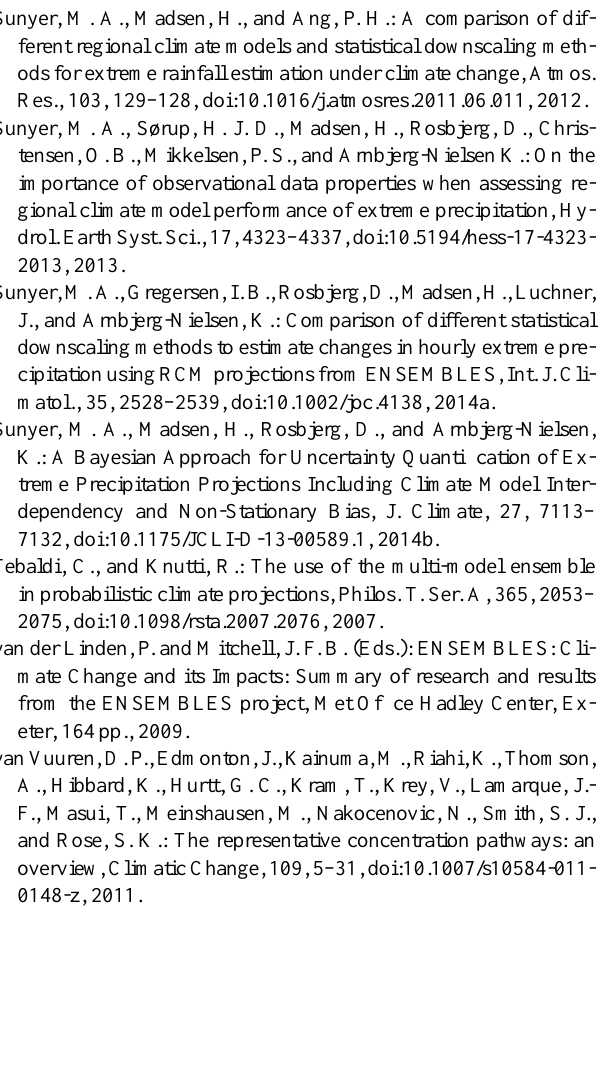
Figueras, T., and Jameleddine, S.: Are Stochastic point rainfall models able to preserve extreme flood statistics?, Hydrol.